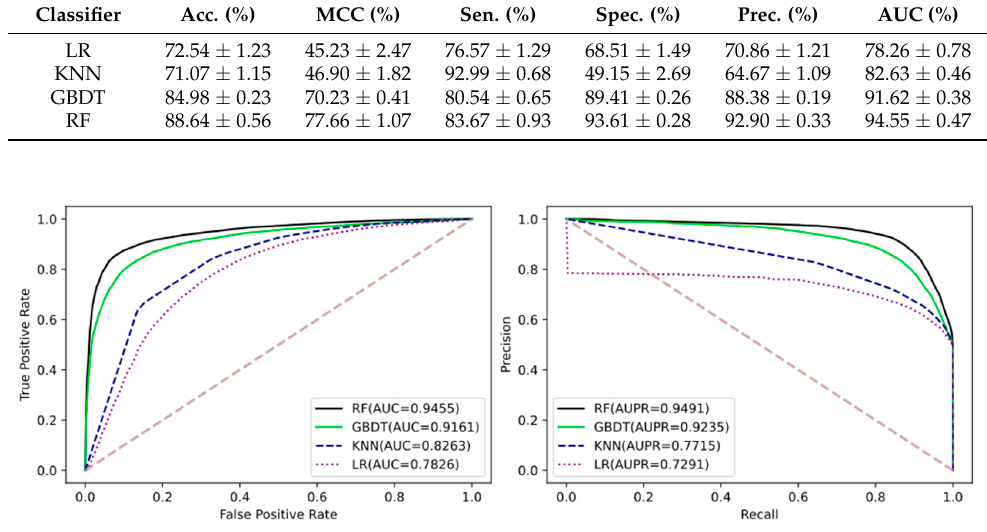
Figure 5. Comparison of the ROC and PR curves performed based on different machine learning